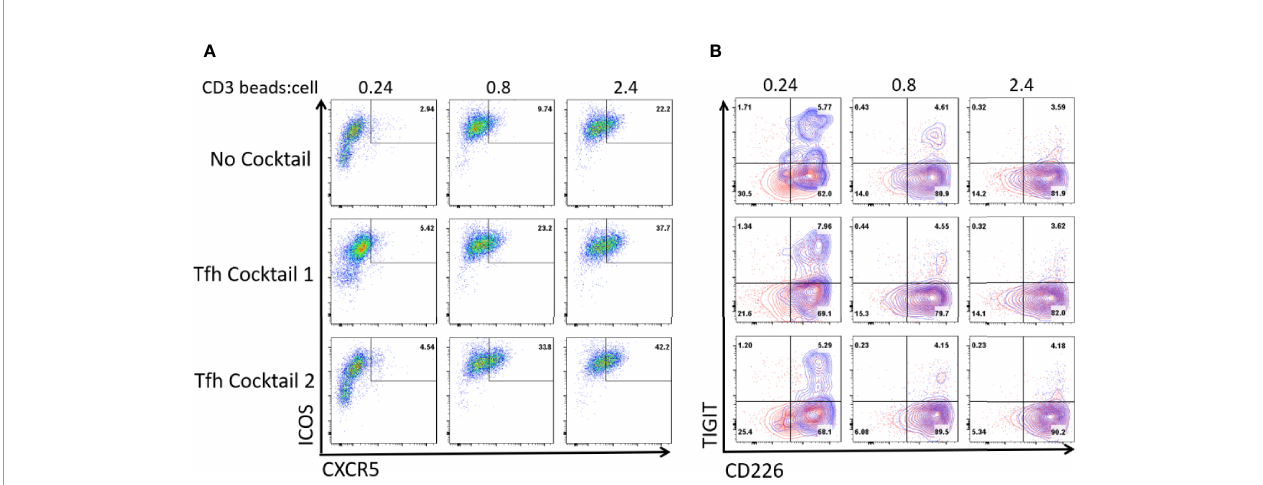
FIGURE 3 | The culture of CD4+ T cells in Tfh-promoting conditions does not induce TIGIT. Total blood CD4+ T cells were cultured in conditions promoting Tfh cell differentiation for 3 days; using Activin A and IL-12 (Tfh cocktail 1) or IL-12, IL-23, rOX40L, and TGF- b (Tfh cocktail 2) in the presence of anti-CD3-CD28 beads at the indicated ratio. (A) ICOS and CXCR5 expression of the cultured T cells. (B) CD226 and TIGIT expression of the total cultured T cells (outlined in red) and on CXCR5 + ICOS + cells (overlayed in blue). Representative FACS plots out of 3